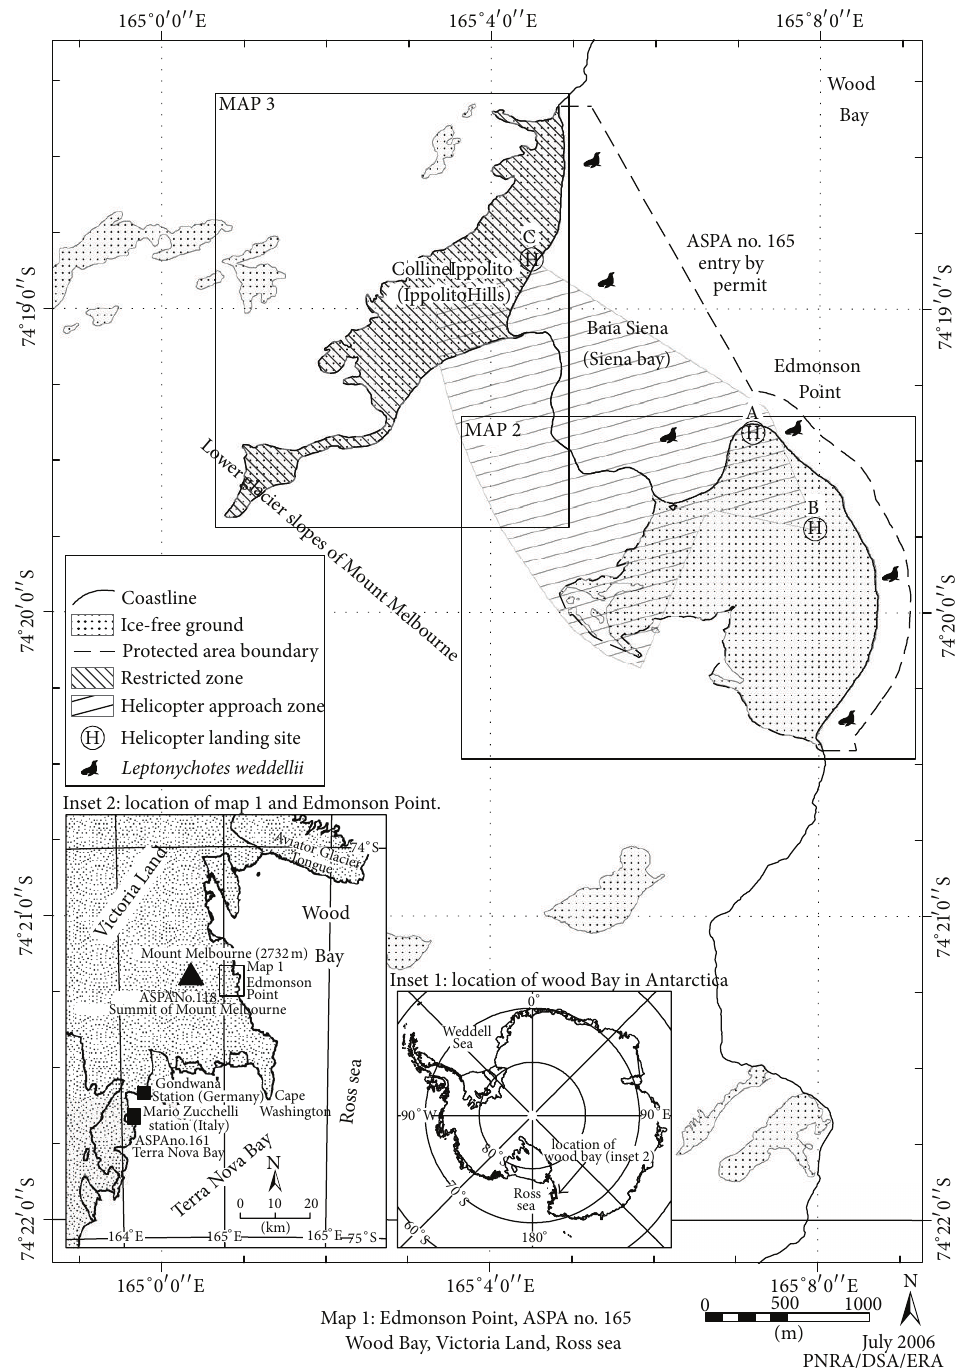
Figure 1: Location map of Edmonson Point in the Victoria